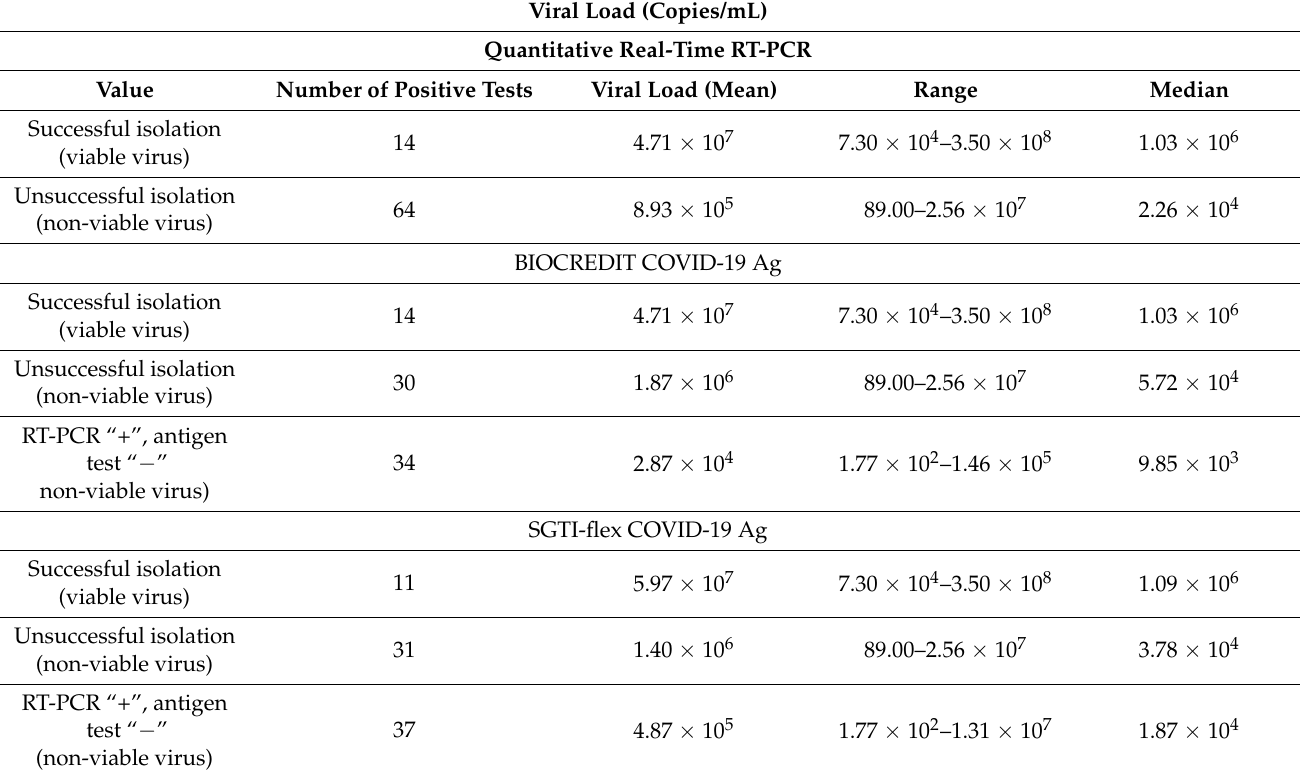
Table 3. Viral load (copies/mL) depending on viability and rapid test result.